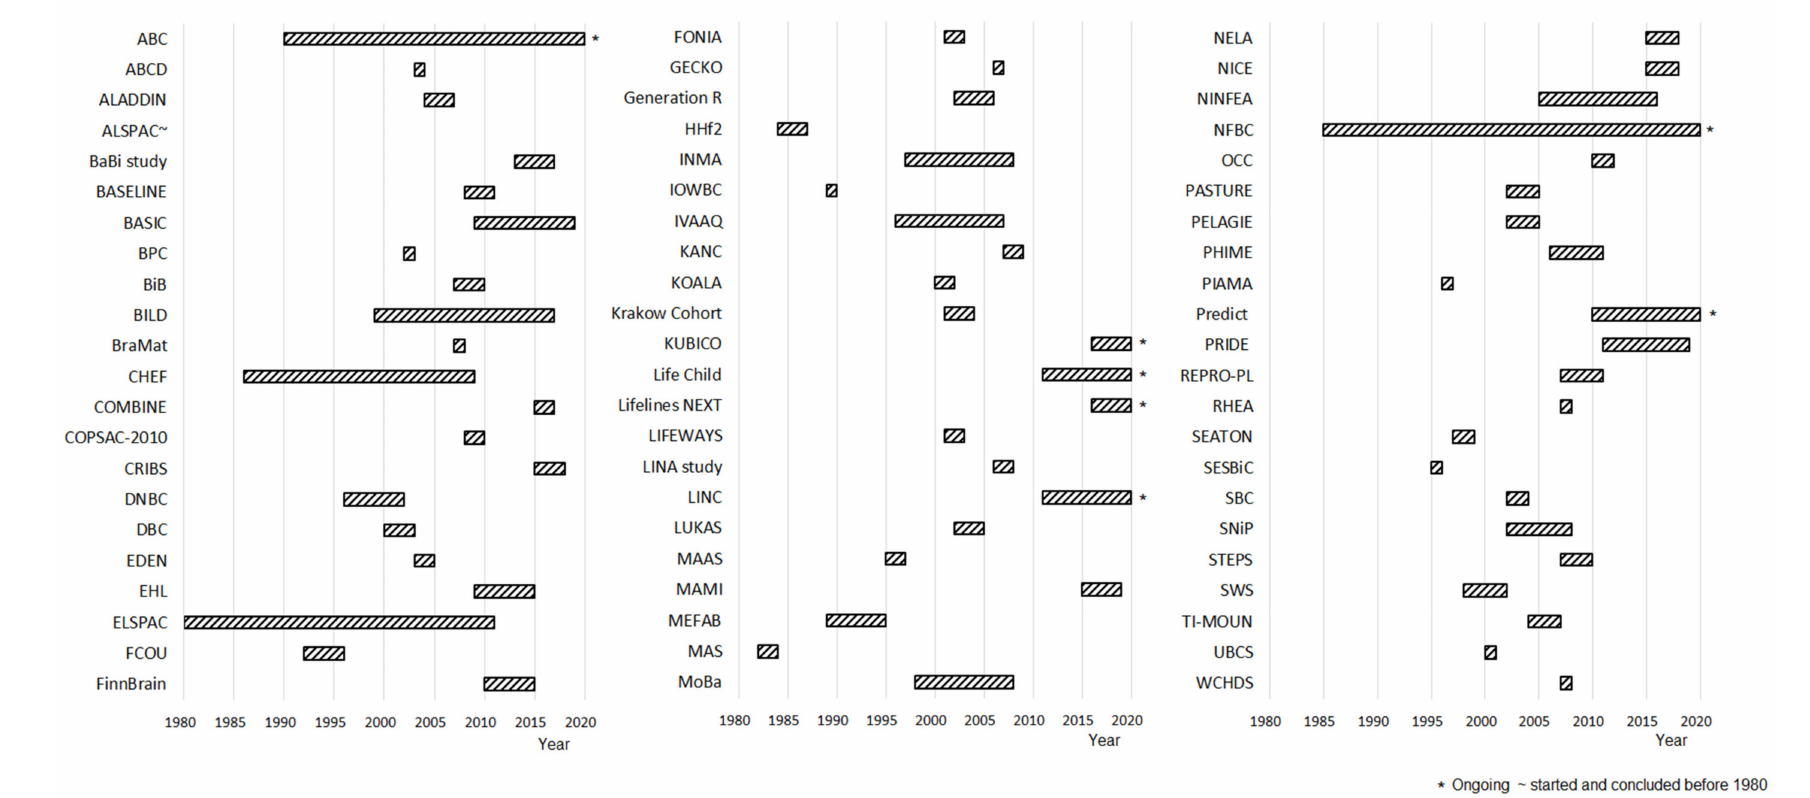
Figure 3. Enrolment starting date and status of the pregnancy cohorts. Pregnancy cohorts were reported by their acronyms as reported in Table 1. Asterisks represent ongoing